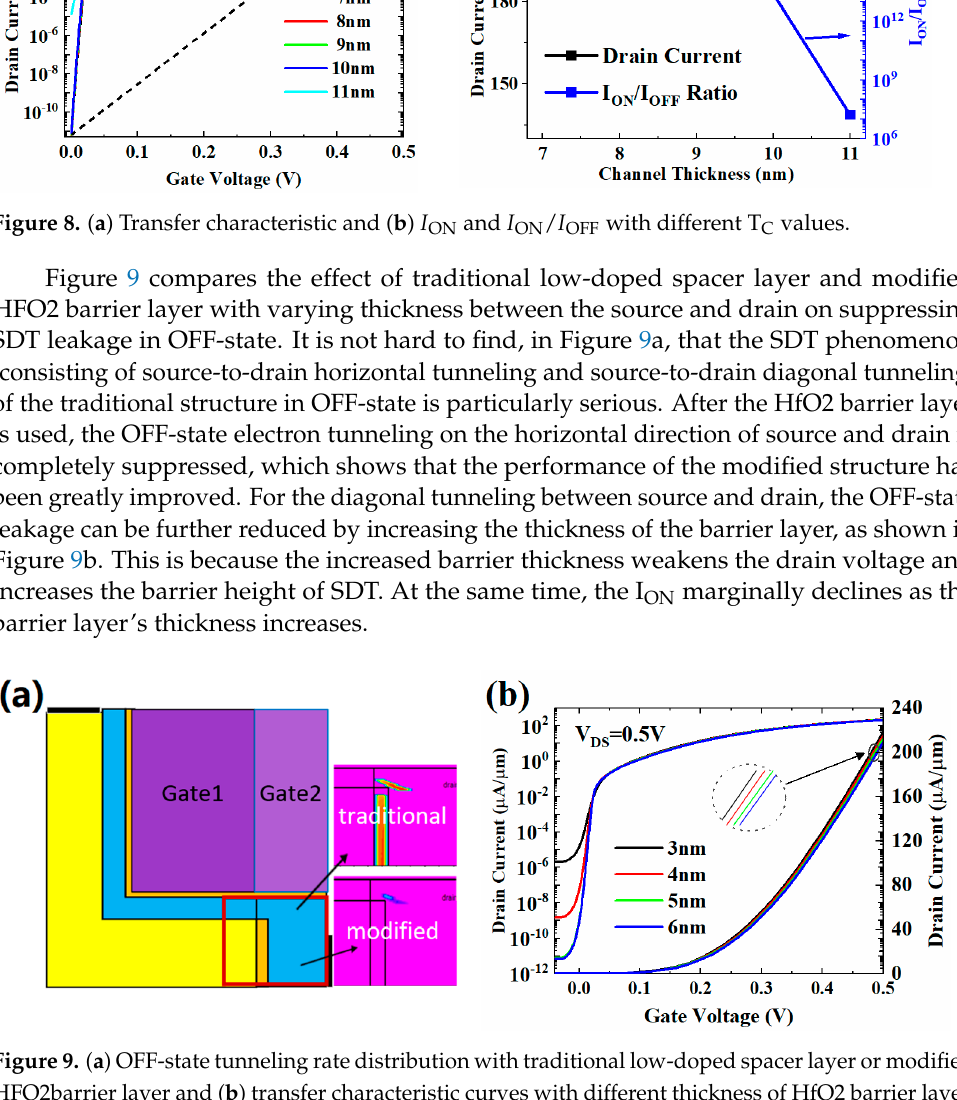
6 of 11 Figure 7. ( a ) Transfer characteristic and ( b ) I ON and I ON / I OFF with different T S values.